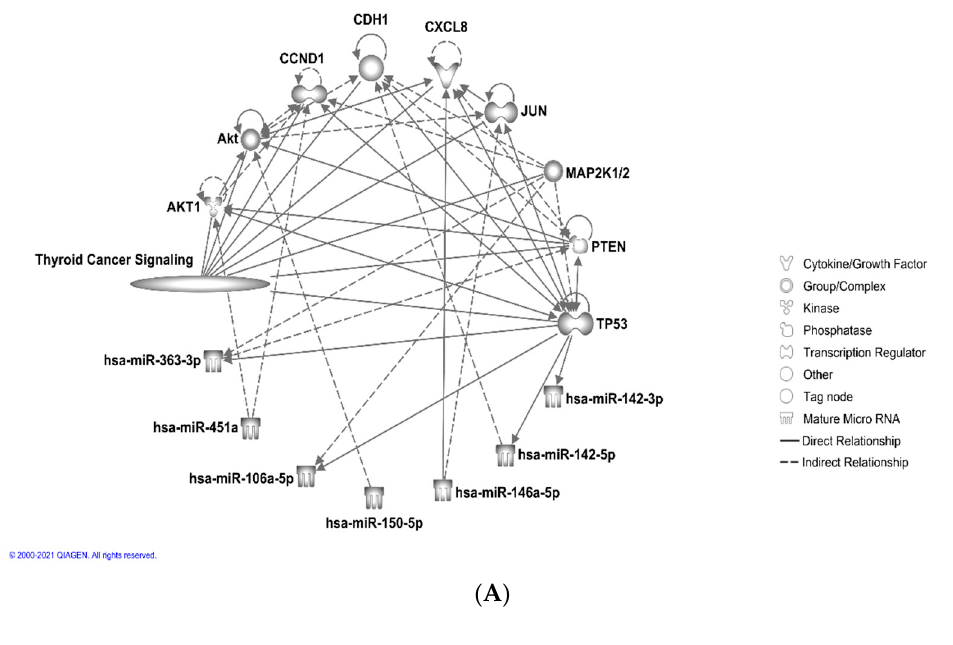
Supplemental Table S7) through molecules such as JAK1/STATA3, RELA, CCL20, NFkB, and HSP90 complexes and a group of interleukins.